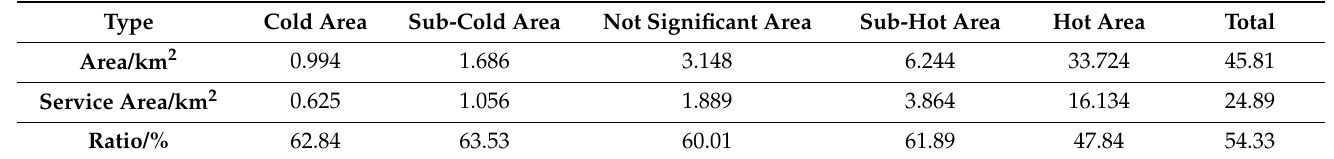
Table 7. Statistics of Comprehensive Service Space of Green Space in Hot Living